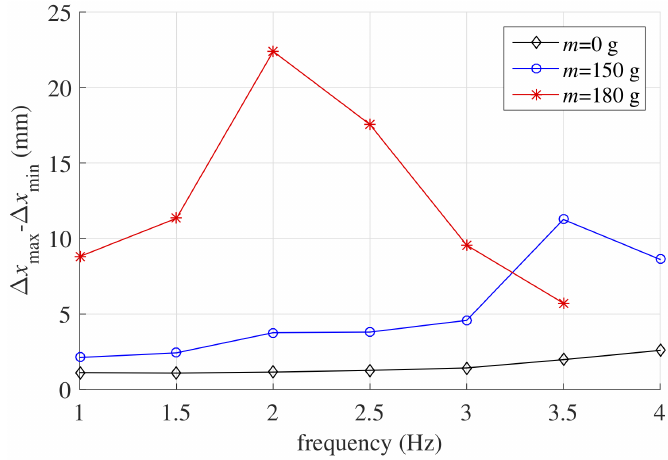
Figure 10. Crest-to-trough oscillation amplitude at different excitation frequencies in isotonic tests with different values of the hung